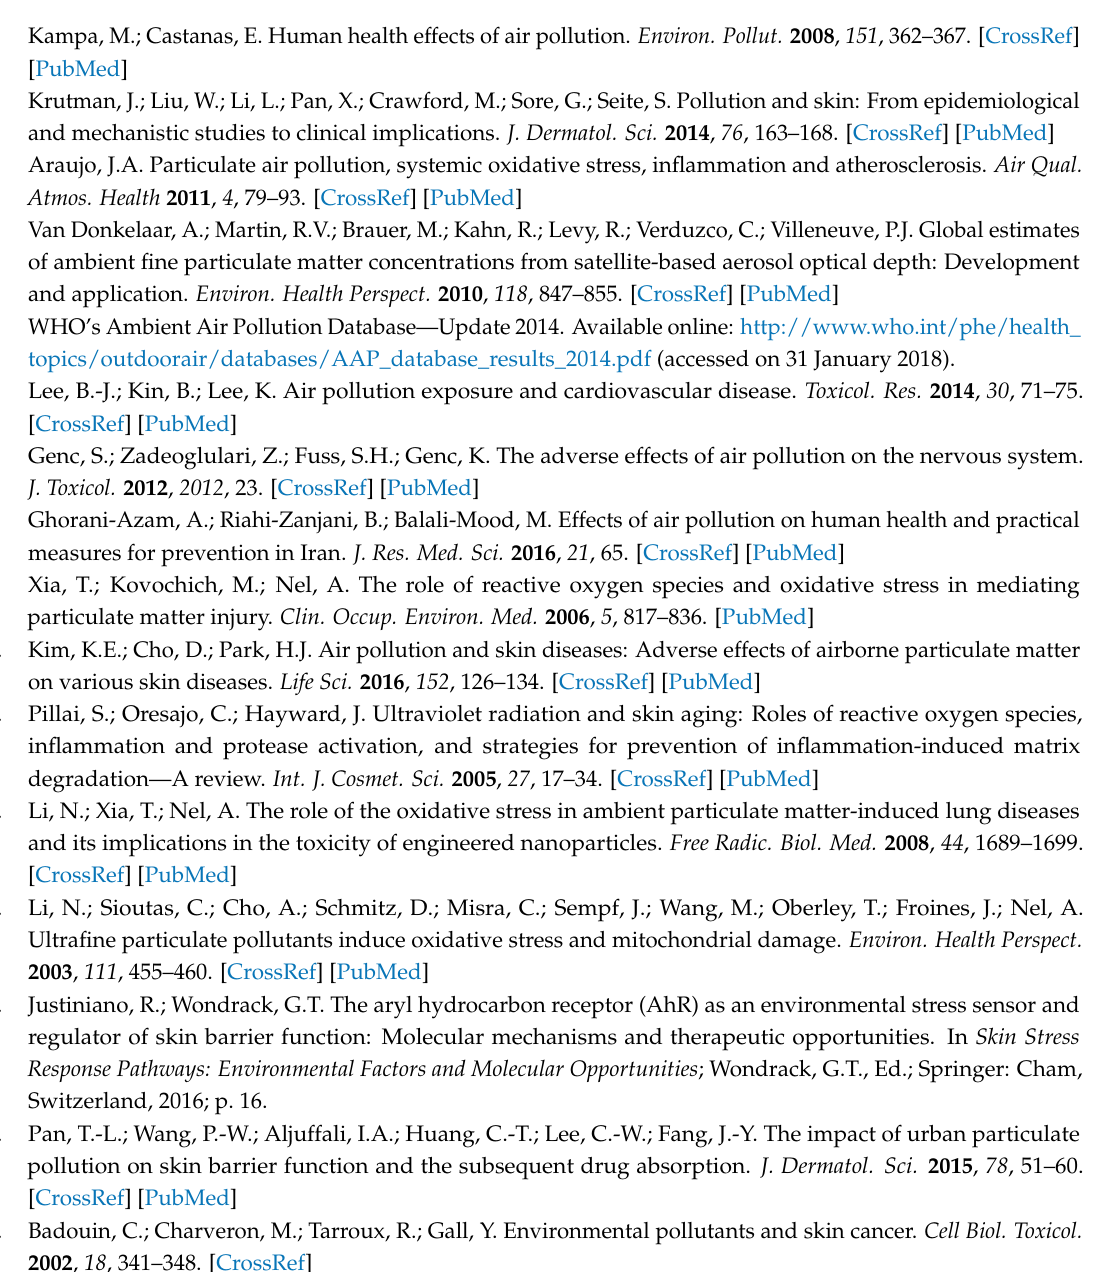
Table S1: Anti-pollution cosmetic ingredients obtained from Algae, Table S2: Anti-pollution cosmetic ingredients obtained from Spermatophytae (n.s. = not